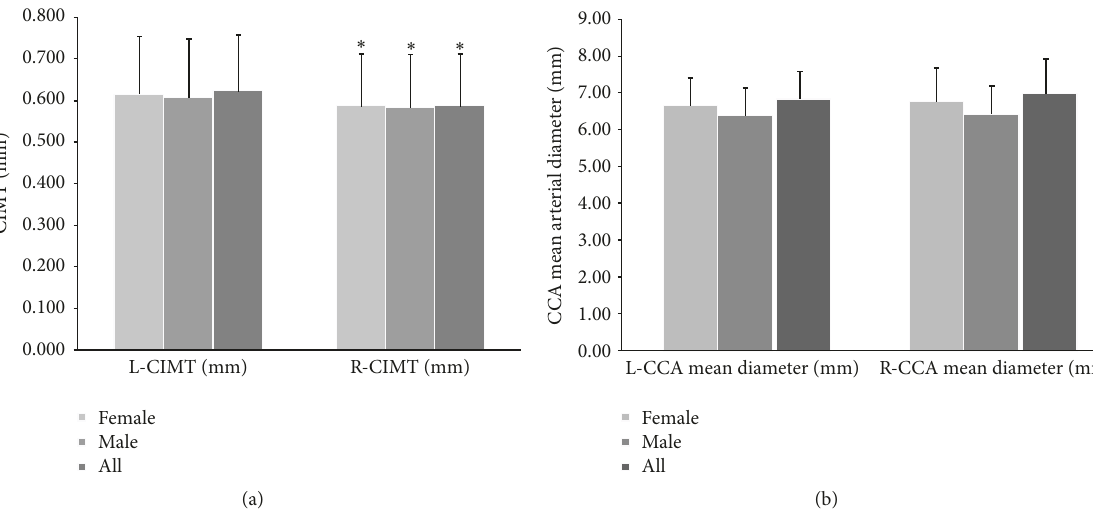
Figure 1: Left and right CIMT (a) and carotid diameter (b) in males, females, and all subject. CIMT: carotid intima media thickness. ∗ Statistically significant